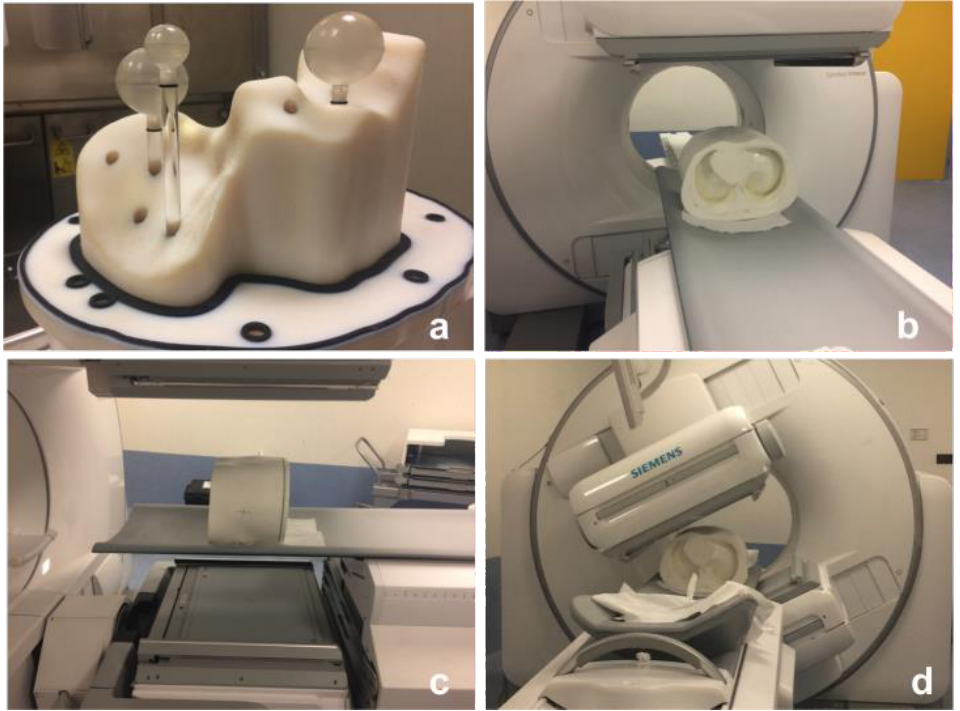
Figure 3. ( a ) The Abdo- Man phantom’s design and schematic illustration indicating how lesion and support rods are placed within the phantom; ( b , c ) the position of phantom on the couch; ( d ) a step of SPECT acquisition.